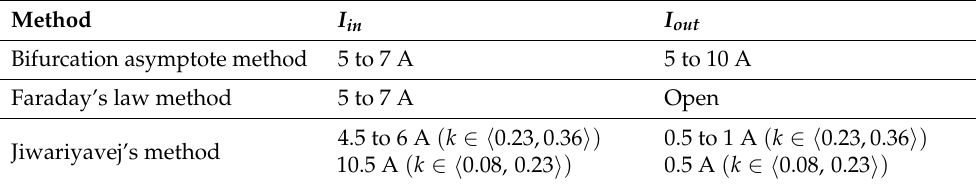
Table 3. Currents used for testing of the estimation